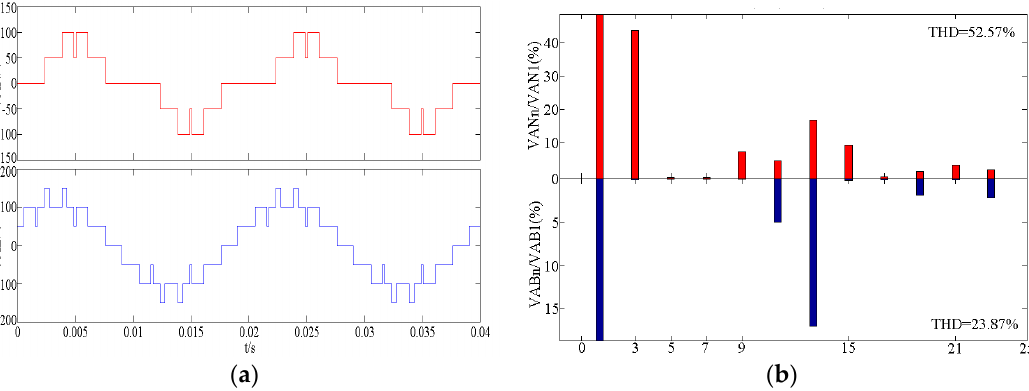
Figure 5. Simulation waveform based on A waveband when U 1 = 3.15. ( a ) Simulation waveforms of phase and line voltages. ( b ) Spectrum distribution of phase and line voltages.